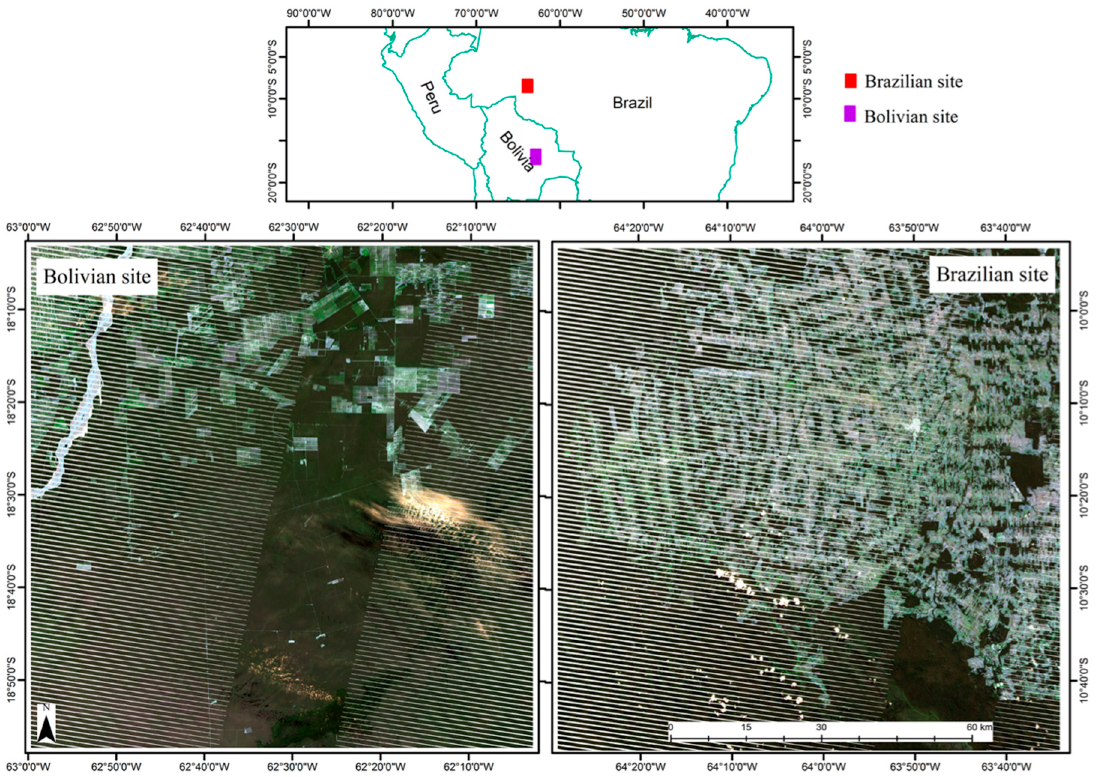
Figure 4. An overview of the location of the study sites south east of Santa Cruz de la Sierra, Bolivia, and west of Ariquemes, Rondonia State, Brazil. The base images are band 1-2-3 composites of Landsat ETM+ images from 15 April 2013 (Bolivia) and 21 July 2014 (Brazil).